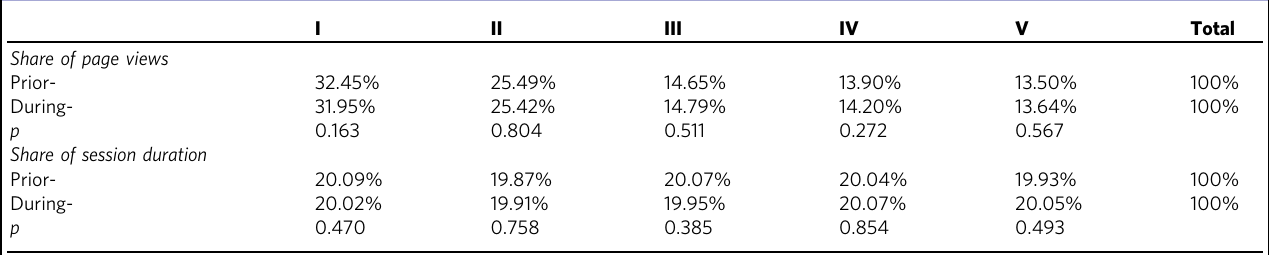
Table 1 Share of page views (above) and session duration (below) of the respective areas of interest 4 weeks prior- and after the beginning of the lockdown (Germany, Austria, and Switzerland).